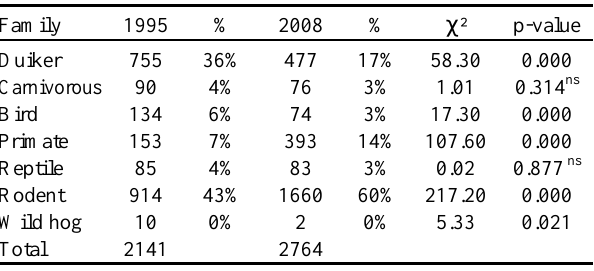
Table 3 . Number of captured animals in the two villages in a year.